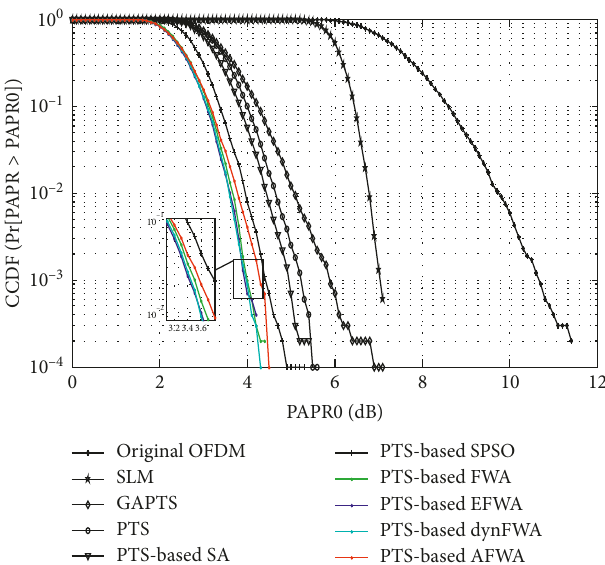
Figure 3: PAPR reduction comparison-based improved version of FWA.